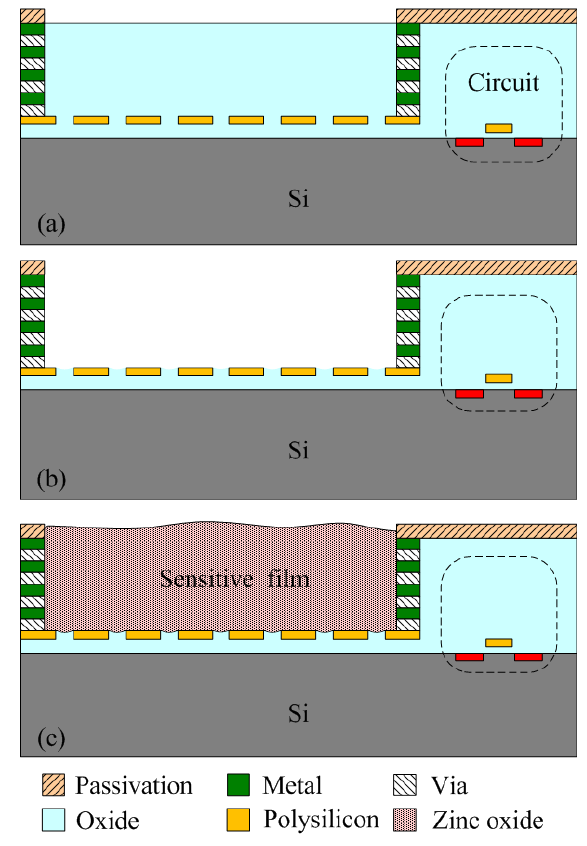
Figure 5. Fabrication process of the ammonia sensor: (a) after the CMOS process, (b) etching the sacrificial layer, (c) coating the sensing film.